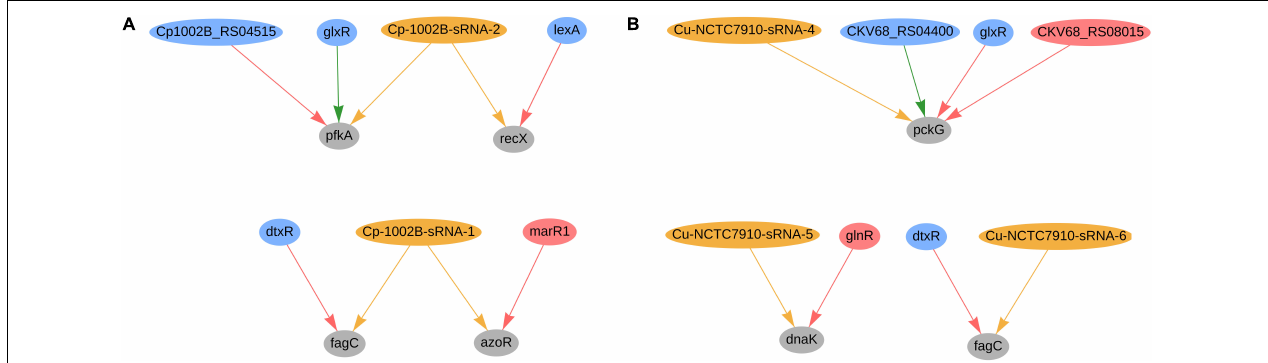
FIGURE 7 | Genes regulated by sRNAs and regulatory proteins in C. pseudotuberculosis 1002B (A) and in C. ulcerans (B) . In the network, green nodes represent activator proteins, red nodes represent repressor proteins, blue nodes represent dual regulators (i.e., that can activate and repress gene expression), orange nodes represent sRNAs and gray nodes represent target genes. The arrows represent the regulatory interactions and its colors represent the same roles as the ones in the nodes.